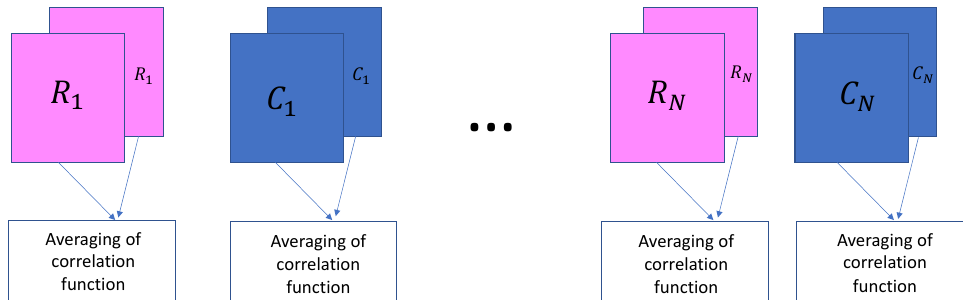
Figure 3. Sequence scheme. R i are rows and C i are columns